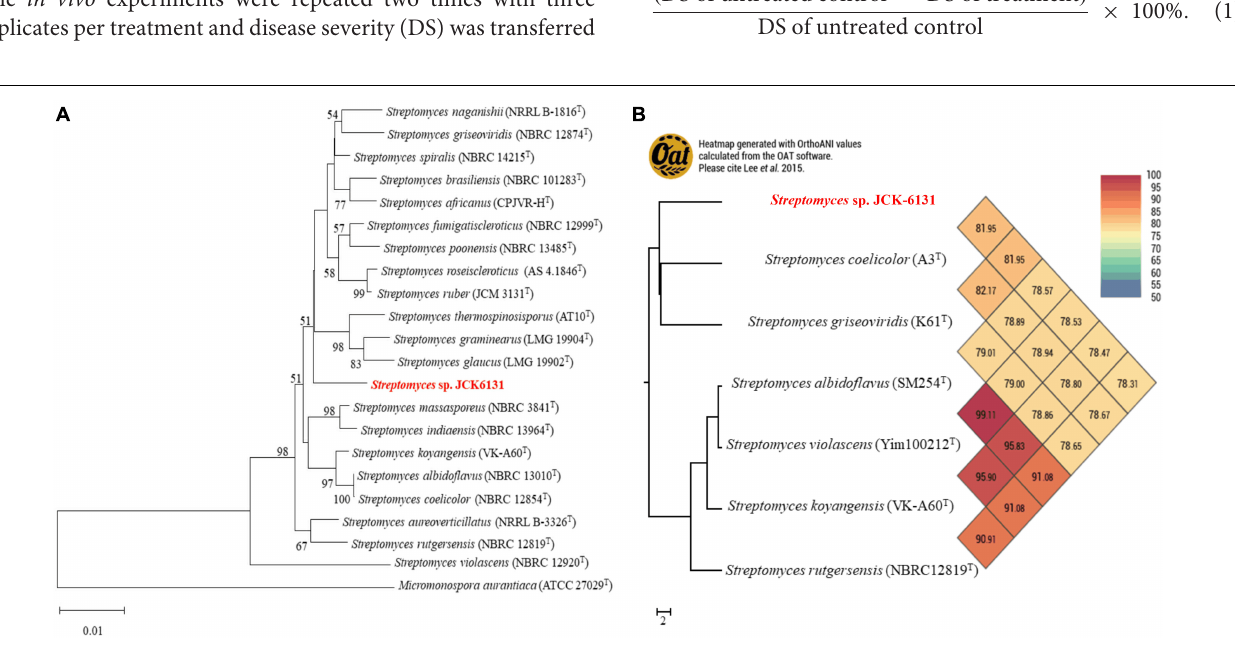
FIGURE 1 | Taxonomic classification of genome comparative of Streptomyces sp. JCK6131 compared to the genome of other related Streptomyces. (A) Phylogenetic relationships between JCK-6131 and related Streptomyces strains represented as a neighbor-joining (NJ) tree based on 16S rRNA gene sequences. The evolution history was determined using the NJ method with a Jukes-Cantor model. The numbers at the branching points represent the bootstrap values from 1,000 replications. Micromonospora aurantiaca ATCC 27029 T was used as the outgroup. Bar = 0.010 substitutions per nucleotide position. (B) Heatmap generated using the OrthoANI values for JCK-6131 and other type strains of Streptomyces species calculated using the OAT software. TABLE 1 | Minimum inhibitory concentration (MIC) of the fermentation filtrate of Streptomyces sp. JCK-6131 against several plant pathogenic bacteria. Plant pathogenic bacteria MIC Fermentation filtrate